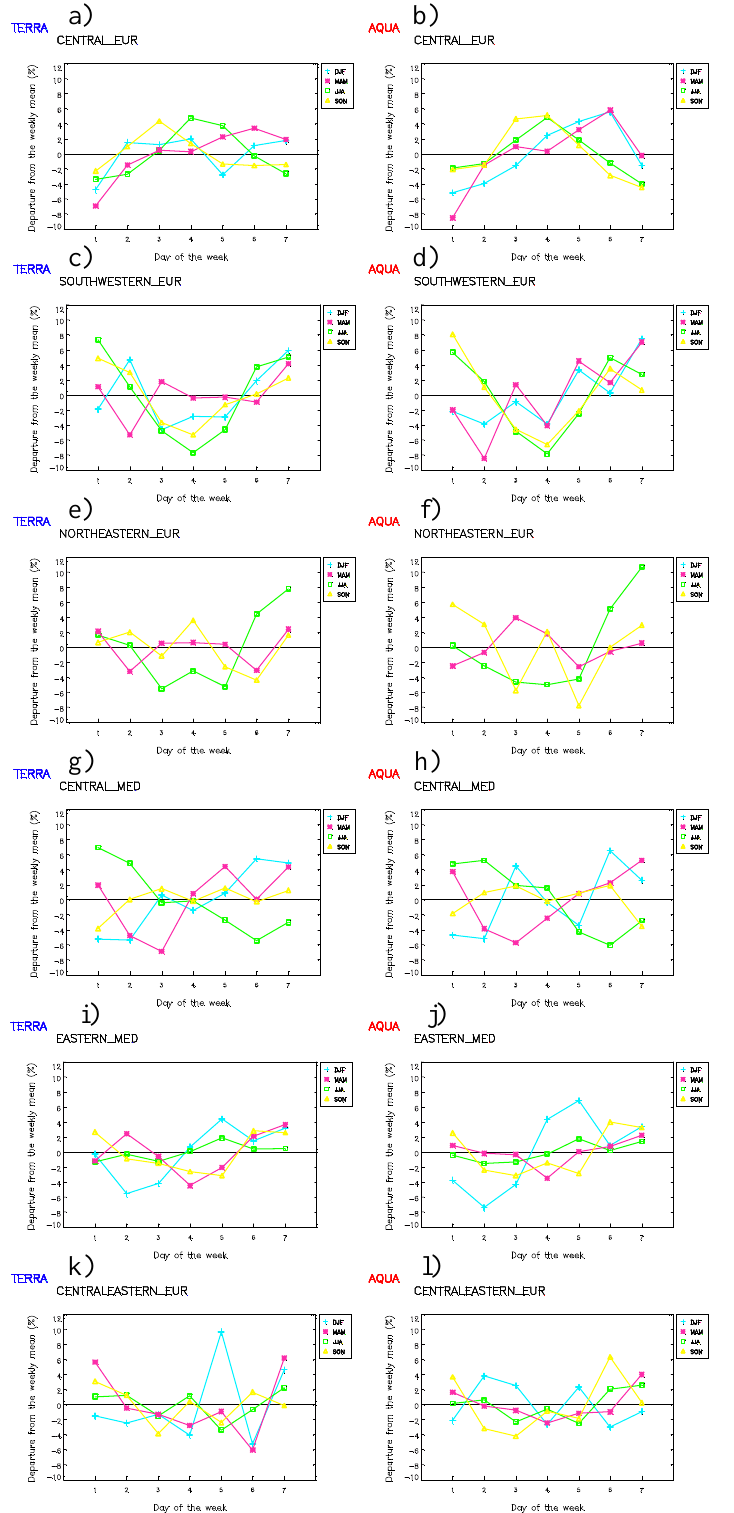
Fig. 6. Seasonal weekly variability of (a) APDs calculated from the CE spatially averaged time series for 7, 6 and 8-day weeks (TERRA MODIS: February 2000–February 2009), (b) APDs calculated from the CE spatially averaged time series for 7, 6 and 8-day weeks (AQUA MODIS: July 2002–December 2008), (c) the same as (a) but for SWE, (d) the same as (b) but for SWE, (e) the same as (a) but for NEE ∗ , (f) the same as (b) but for NEE ∗ , (g) the same as (a) but for CM, (h) the same as (b) but for CM, (i) the same as (a) but for EM, (j) the same as (b) but for EM, (k) the same as (a) but for CEE, (l) the same as (b) but for CEE. ∗ Winter APD variability for NEE is not presented here due to the limited amount of AOD 550